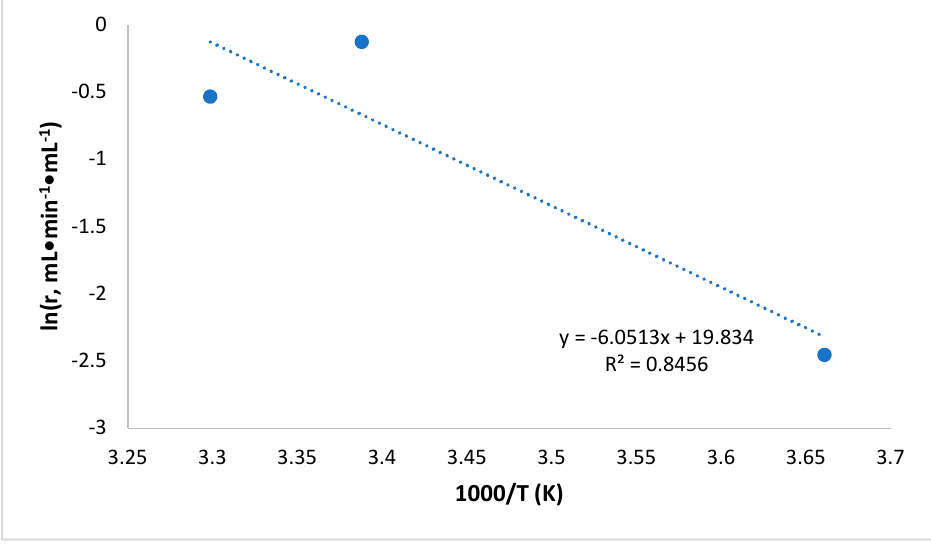
Figure 9. Arrhenius plot used to determine the activation energy of the silver nanoparticle network (50.3 kJ/mol). Table 1. Reported activation energies for NaBH 4 hydrolysis by catalyst.